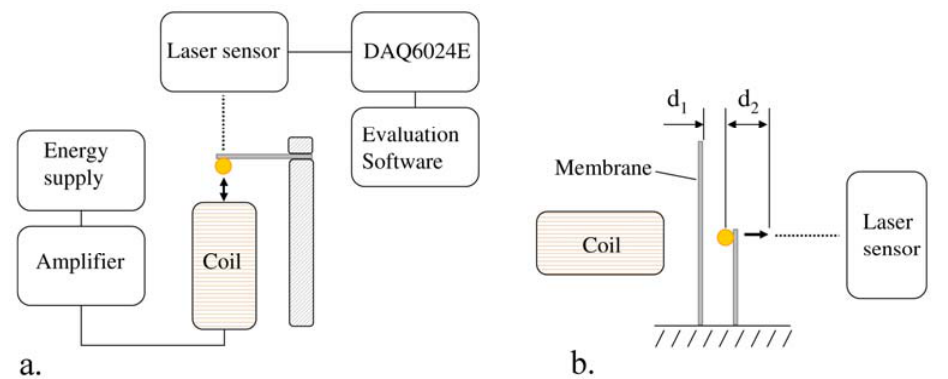
Figure 2. Scheme of the experimental setup. ( a ) Measurement of the eigenfrequency of the oscillator. ( b ) Measurement of the displacement d first impingement, to find the ideal distance d the membrane.